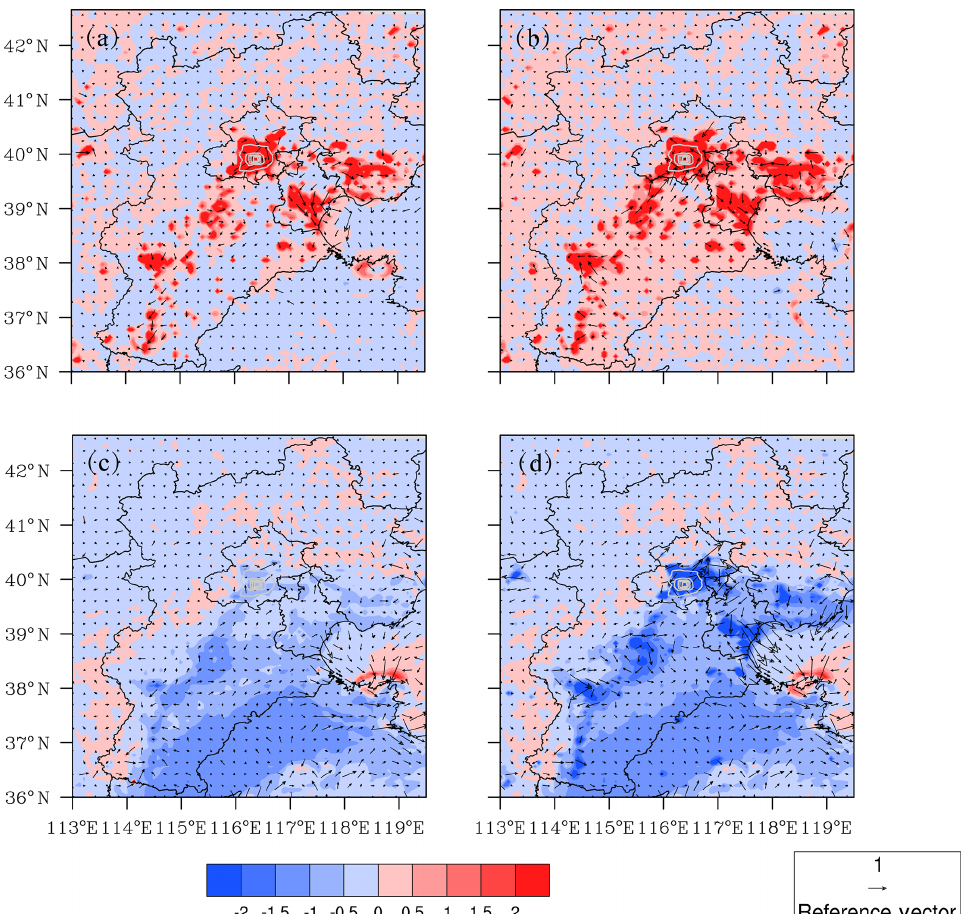
Figure 8. Spatial distribution of simulated temperature (shading; ◦ C) and wind field (vector; ms − 1 ). (a) UI_aero; (b) UI_noaero; (c) AI_urban; (d)